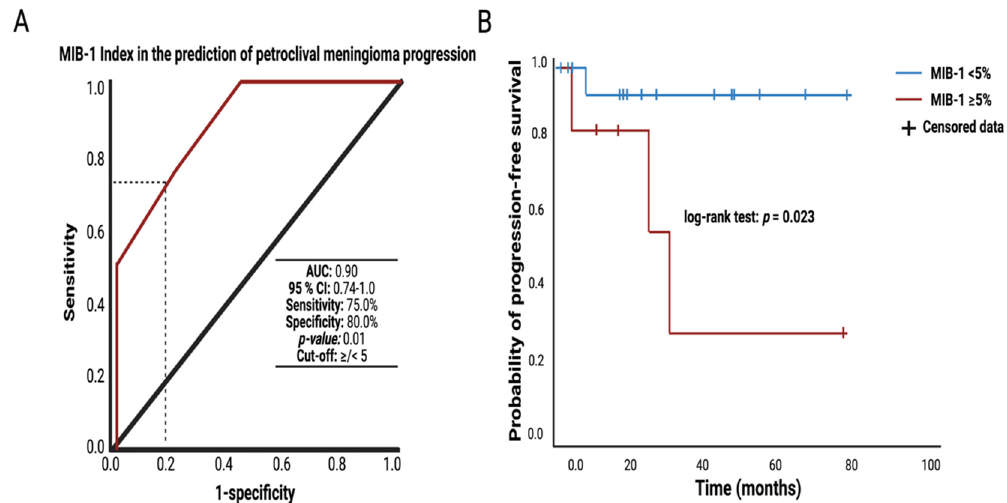
Figure 5. ( A ) Receiver-operating characteristic curve (ROC) illustrating the diagnostic power and the optimum cut-off value of the MIB-1 index in the association with petroclival meningioma progression after surgery for primary sporadic petroclival meningioma via the retrosigmoid approach. ( B ) Kaplan–Meier charts displaying the probability of progression-free-survival stratified by MIB-1 labeling index <5% (blue line) and MIB-1 labeling index ≥ 5% (red line). Censored patients (stable disease at last follow-up) are indicated on the curves. The time axis right-censored at 100 months. p = 0.023 (Log-rank test).